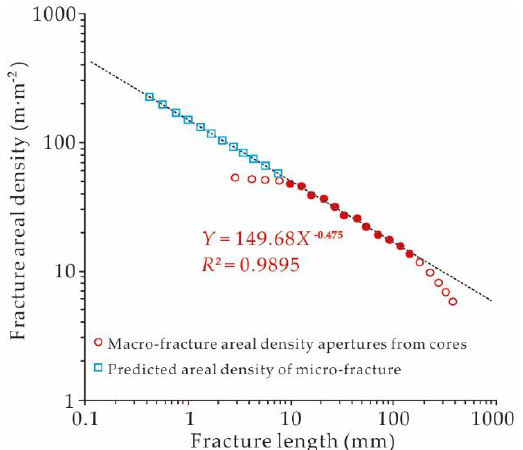
Figure 13. Cumulative plot of macro-fracture areal density (red circles) and prediction of micro-fracture areal density (blue square). The Equation was obtained by fitting the solid circle data, the opening squares are predicted areal density of micro-fractures by extrapolating the power law of cumulative areal density distribution of macro-fractures. Table 3. Comparation of the measured and predicted areal density of micro-fractures.